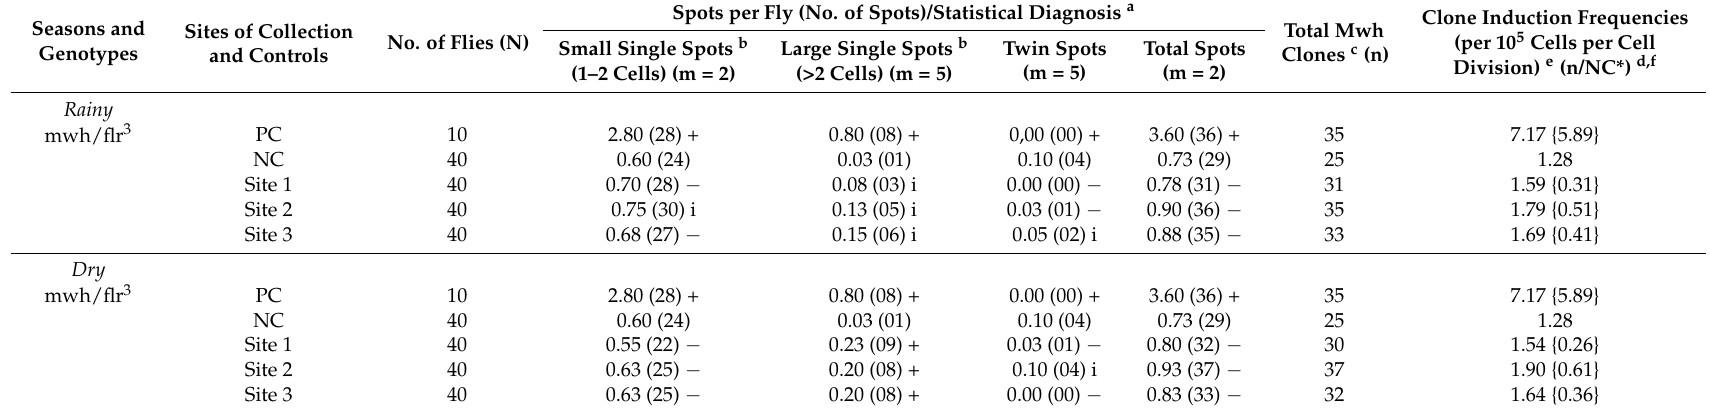
Table 3. Fly spot data obtained after exposure of marker heterozygous larvae of D. melanogaster to surface water of Tocantins River in ST cross. Seasons and Sites of Collection Genotypes and